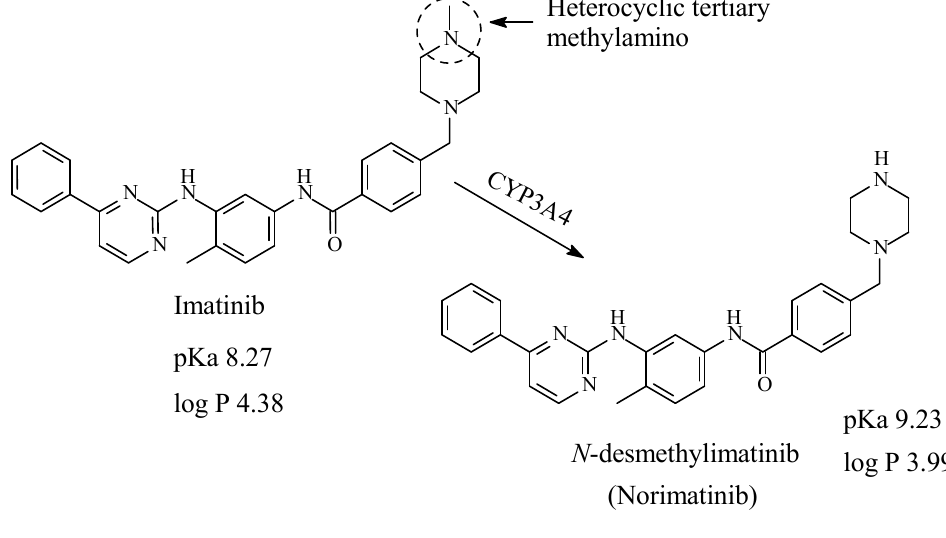
Figure 40. Metabolism of imatinib.